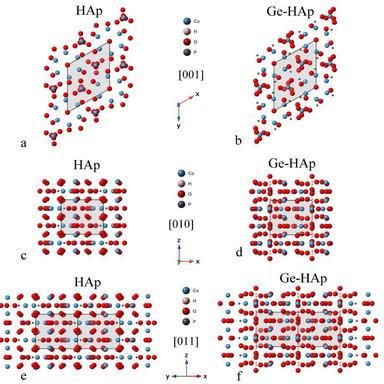
Crystal structures of HAp (a, c, e) and Ge-HAp (b, d, f) plotted using the atomic coordinates obtained from the Rietveld refinement. Projections are down the c, axis (a–b), b, axis (c–d), and axis (e–f). The unit cell of HAp is demarcated in gray.